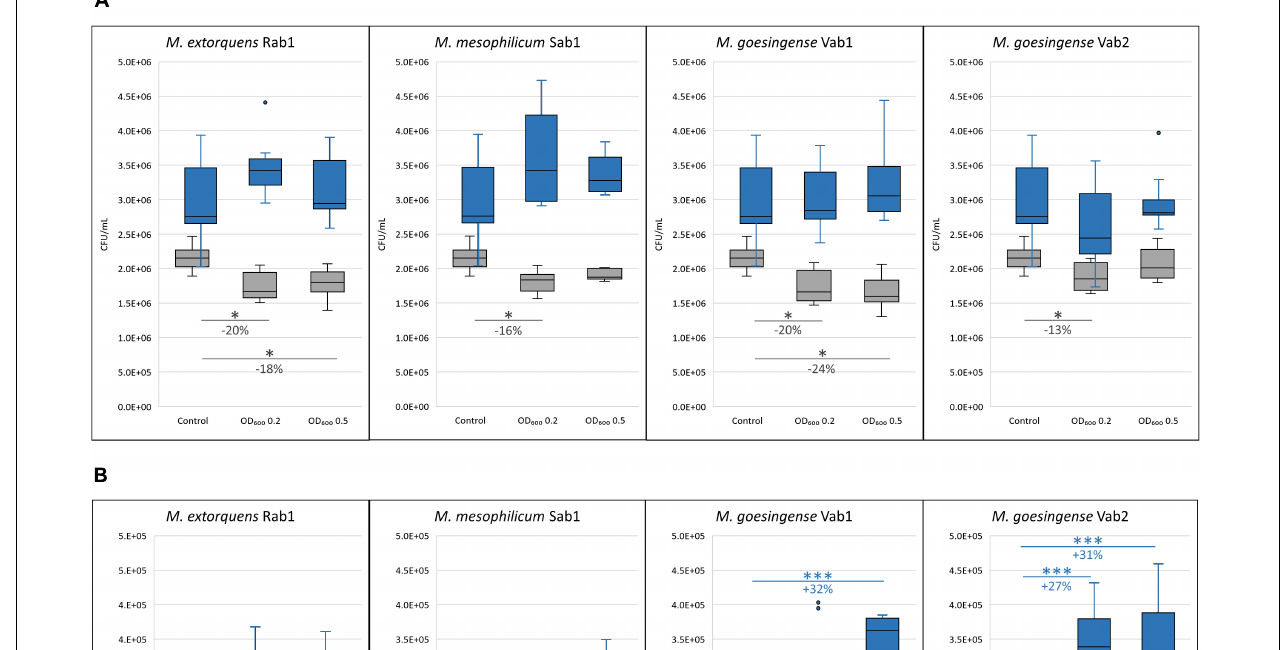
Frontiers in Microbiology |